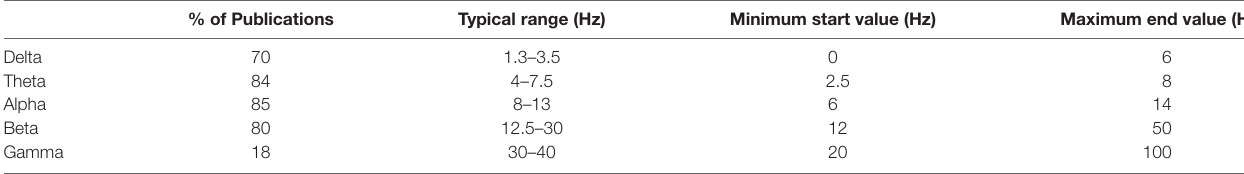
TABLE 2 | Summary of frequency band parameters.